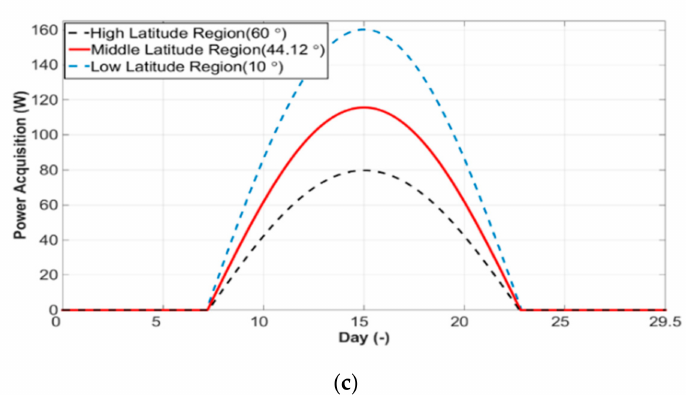
Figure 1. Solar elevation, azimuth angles, and power acquisition according to various landing sites on the Moon: ( a ) solar elevation angles; ( b ) solar azimuth angles; ( c ) power acquisitions.